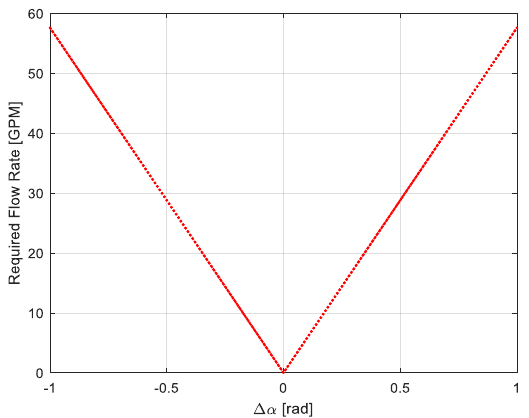
Figure 9. Relationship between changes of hitch arm angle vs. required flow rate .